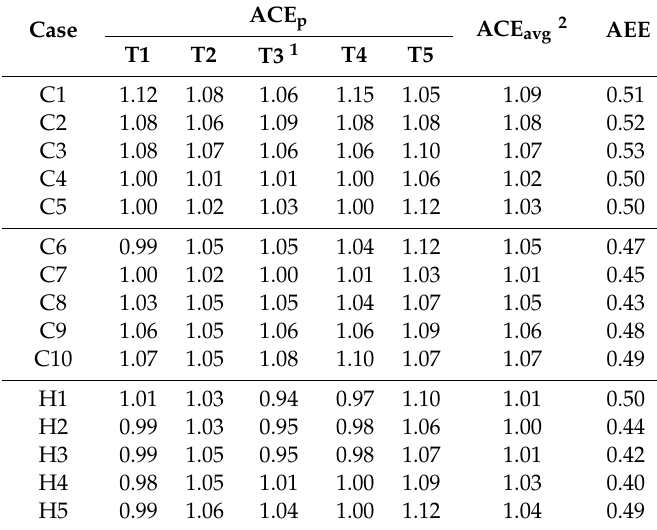
Table 5. Air change e ff ectiveness (ACE), local and average, and air exchange e ff ectiveness (AEE).